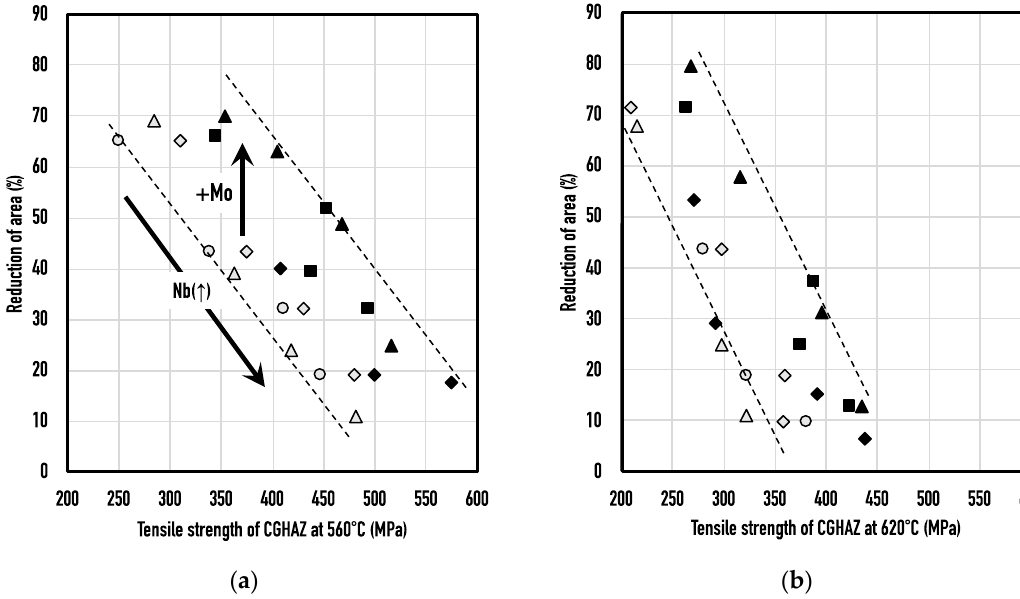
Figure 9. Reduction of area vs. hot-tensile strength of coarse-grained zone (CGZ) treated material at a test temperature of ( a ) 560 °C and ( b ) 620 °C.